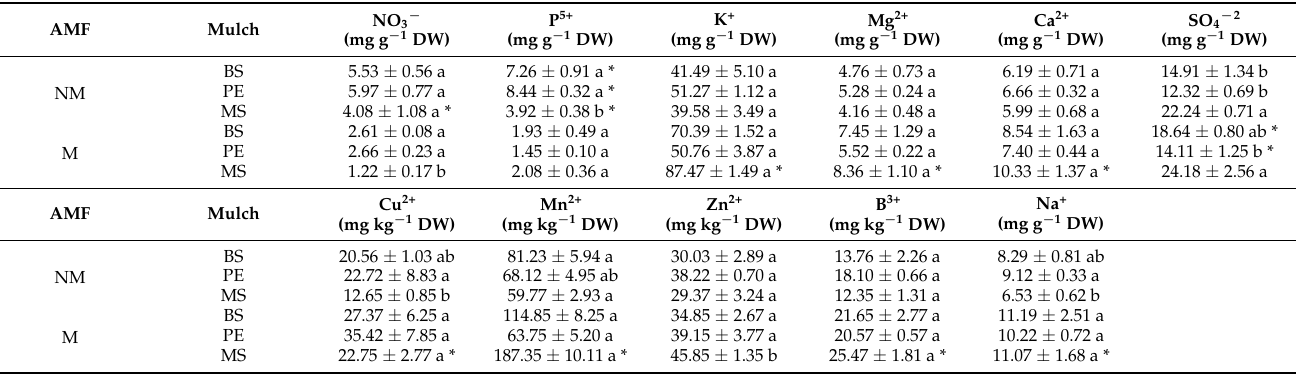
Table 2. Mineral nutrient concentrations in roots of escarole plants (cv. Bekele) cultivated under non-mycorrhizal (NM) and mycorrhizal (M) conditions and covered or not with mulching treatments.